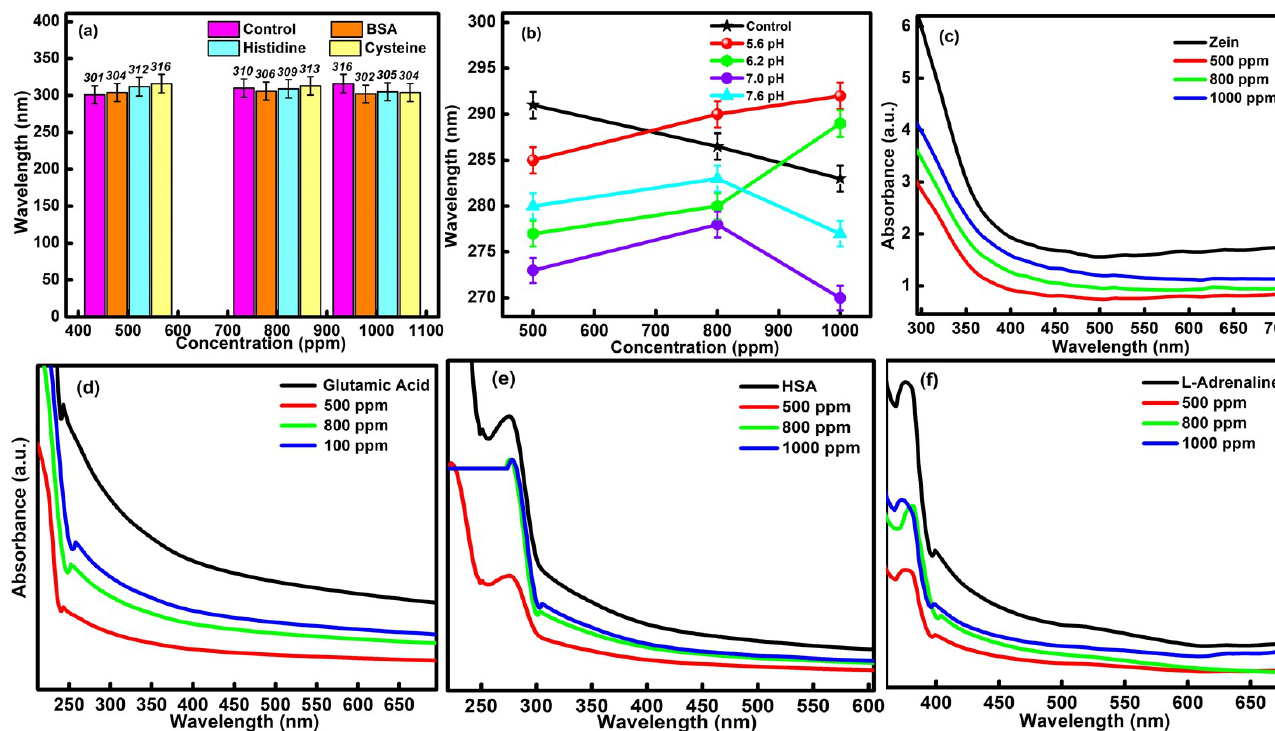
Figure 5. ( a ) In vitro stability activity in the presence of various essential blood elements (BSA, histidine and cysteine), ( b ) variations in the wavelength of C-dots in different pH buffer solutions (pH = 5.6, 6.2, 7.0 and 7.6) and the colloidal stability assay in the presence of ( c ) Zein, ( d ) Glutamic acid, ( e ) HSA and ( f ) L-adrenaline.